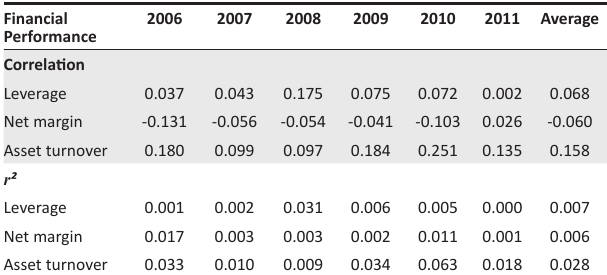
the CEO guaranteed CTC. Both means were used.